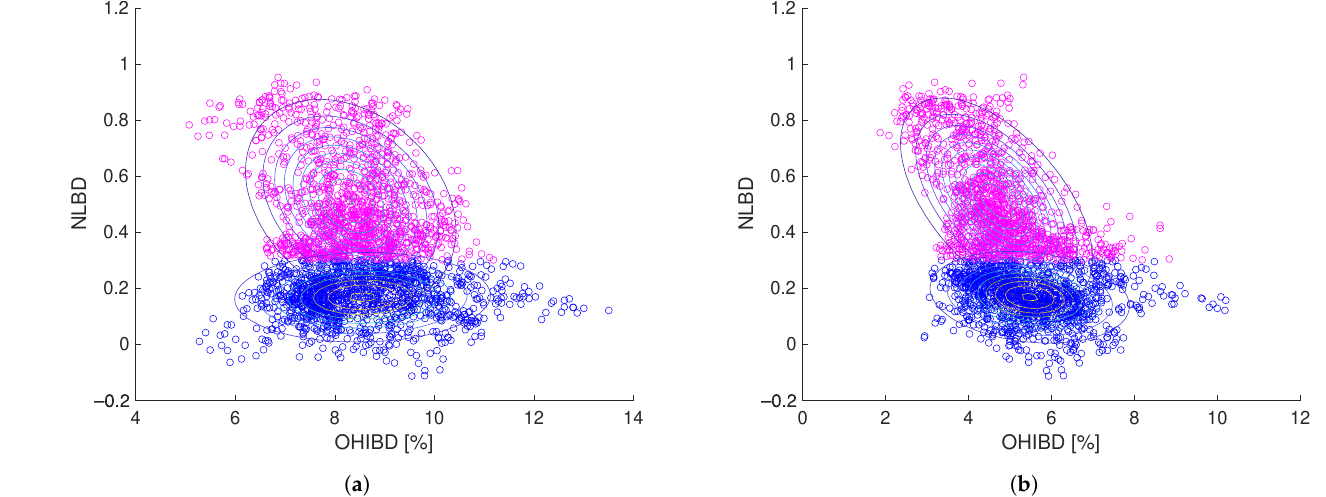
Figure 14. Scatter plots of the NLBD value vs. OHIBD value for the region of interest in Figure 15b. The correlation coefficients listed in the sub-captions are calculated for the cluster assumed to contain spinel, corresponding to all pixels with NLBD values exceeding 0.3 (magenta circles). The correlation coefficients for the regions not containing spinel (blue circles) are r = 0.043 and r = − 0.195 for morning and midday, respectively. ( a ) At 09:20 local time. r = − 0.295, ( b ) at 11:15 local time. r = −